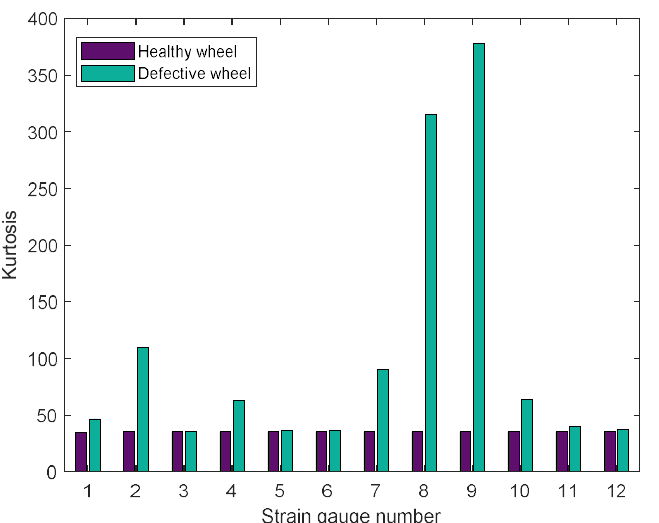
Figure 10. Kurtosis values for healthy and defective wheels corresponding to 12 positions of the strain gauges for the passage of the Alfa Pendular.